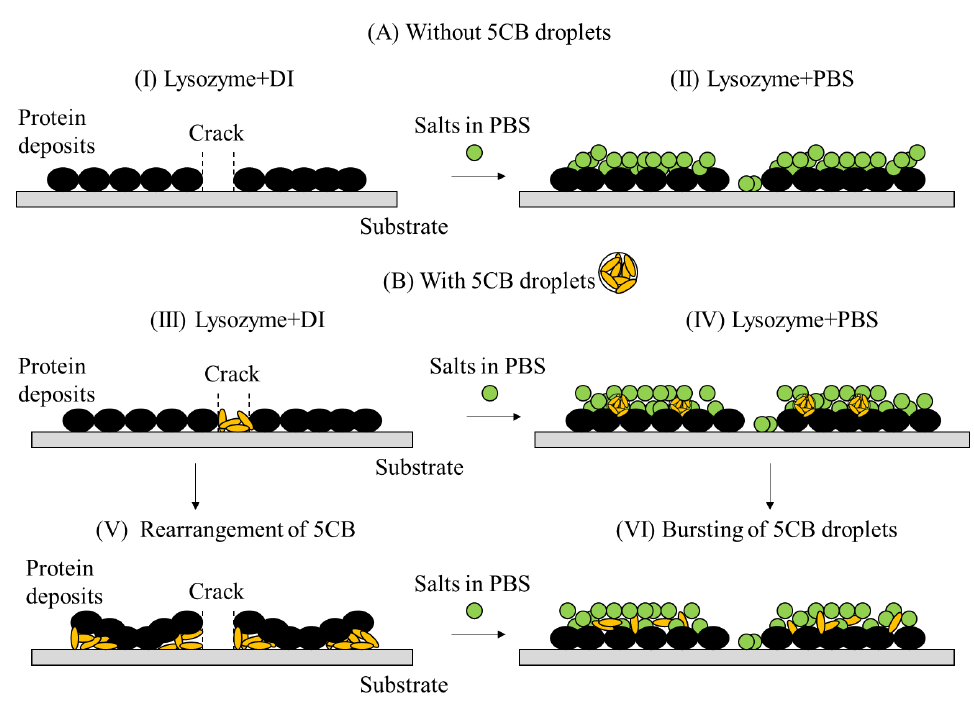
Figure 12. A schematic representation of lysozyme drops prepared in different concentrations of PBS ( φ PBS ) with and without LC droplets is shown in this figure. ( A )(I,II) depicts the changes in the central region of the drop when we add concentrated φ PBS . ( B )(III–VI) illustrates how the LC droplets affect the distribution of proteins, salts, and the final morphological